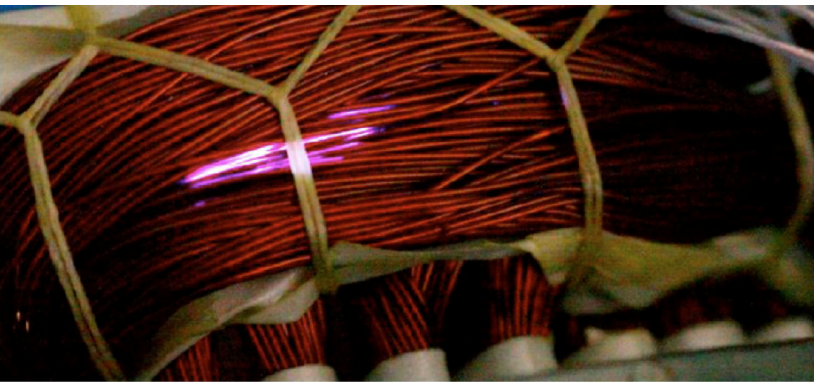
Figure 25. Typical partial discharge activity between adjacent turns in an inverter-fed motor [97].